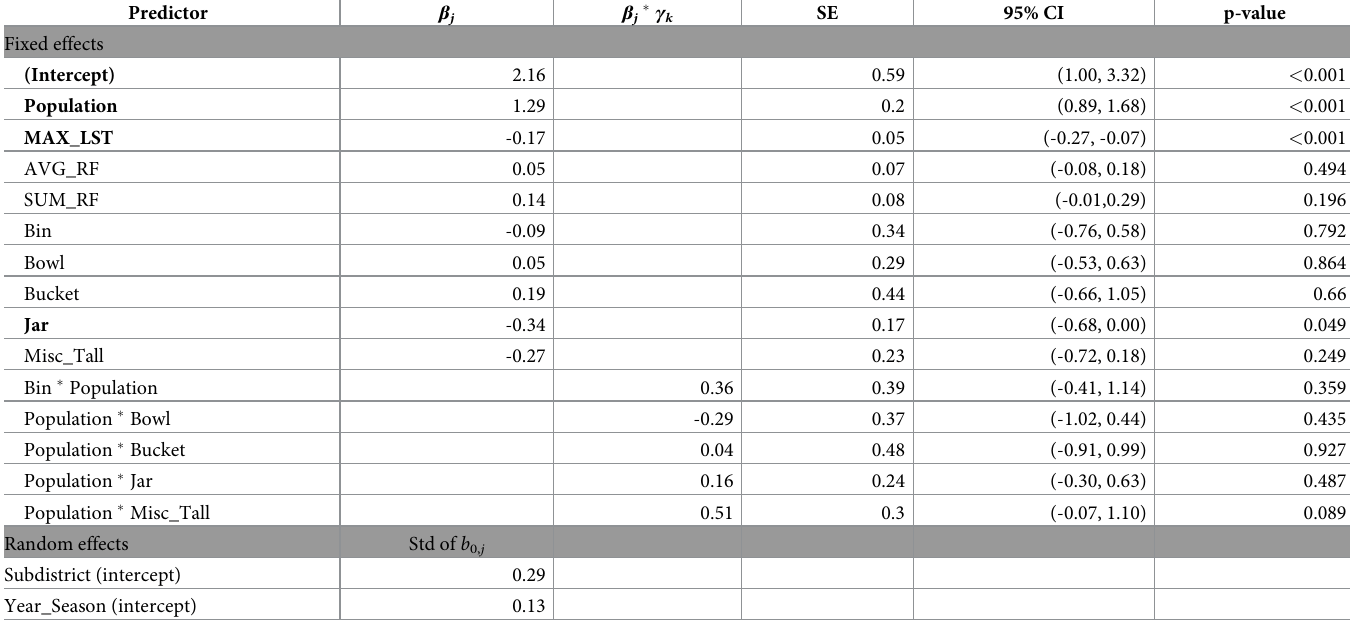
Table 6. The coefficients of the LMER+C model using training data (2015–2017) for Nakhon Si Thammarat province. Significant variables with a p-value < 0.05 are indicated with boldface. Predictor